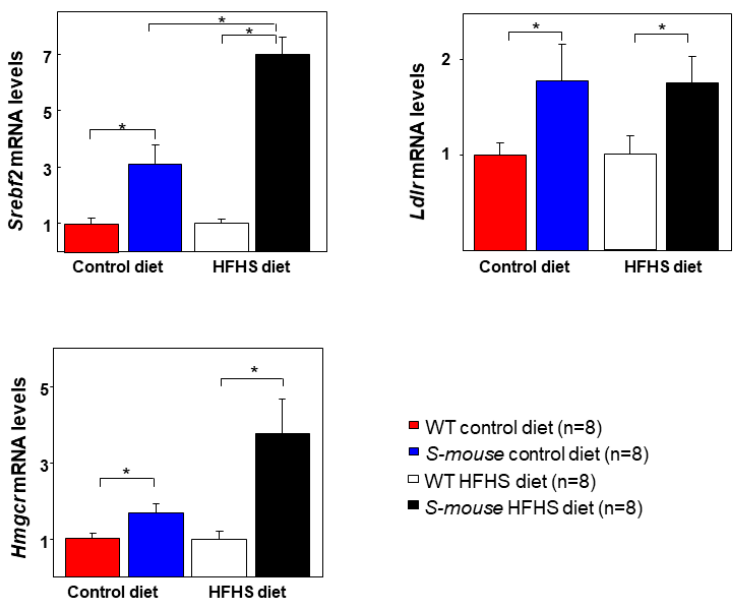
Figure 6. Expression analysis in liver in WT and S-mice fed high-fat, high-sucrose or control diet for 16 weeks. Srebf2, Ldlr and Hmgcr hepatic mRNA levels were normalized to actin- β expression. Relative expression shown was calculated using the 2 − ( ∆∆ Ct) method. Statistical analysis was performed using one-way ANOVA. * p ≤ 0.05. HFHS high-fat, high-sucrose, Srebf2 Sterol regulatory element-binding transcription factor 2, Ldlr Low-density lipoprotein receptor, Hmgcr 3-Hydroxy-3-methylglutaryl-CoA